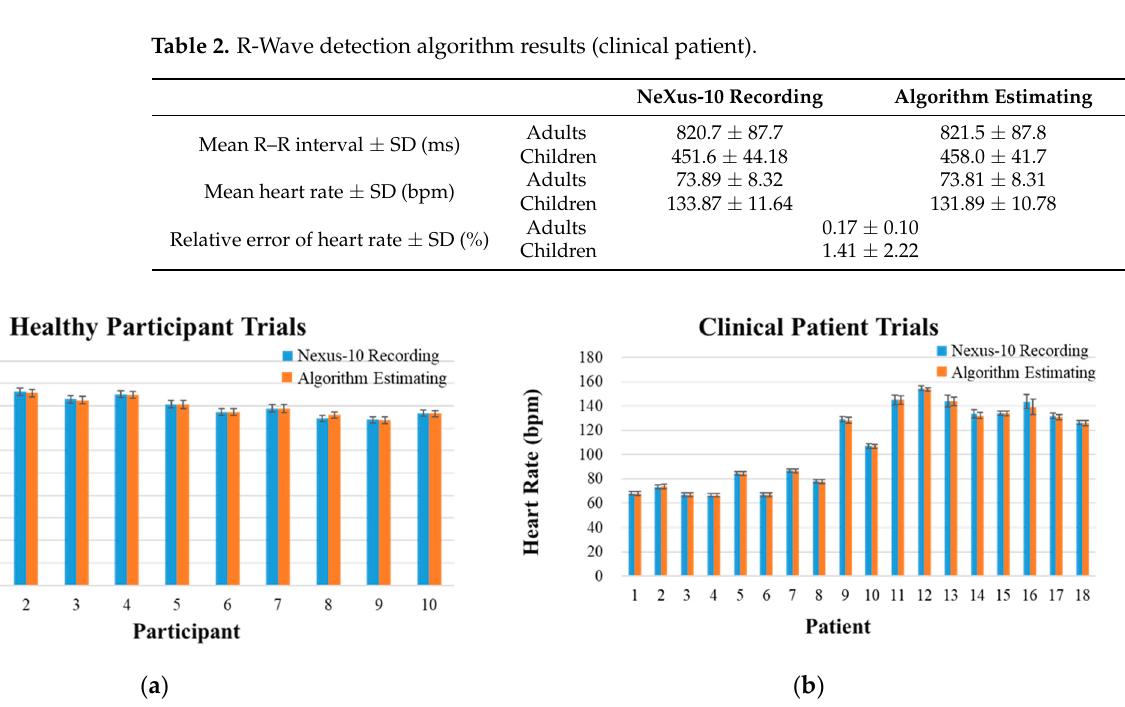
Table 2. R-Wave detection algorithm results (clinical patient).